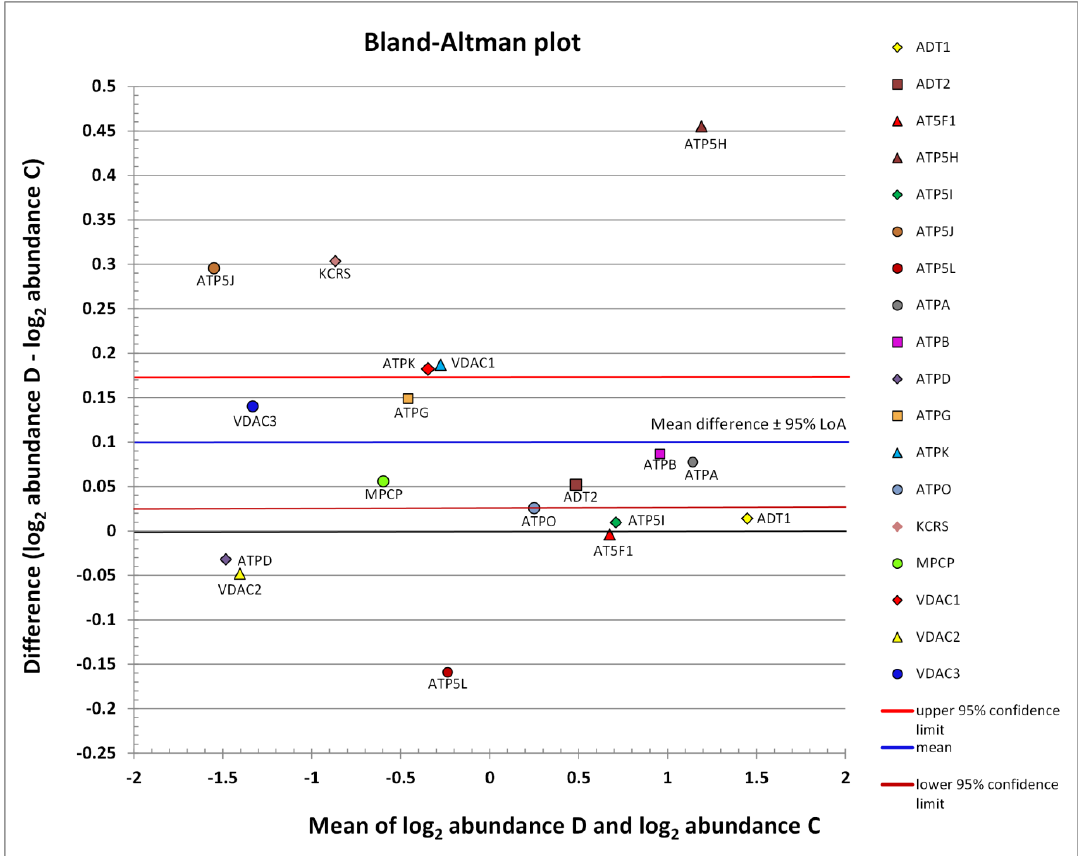
Figure 2. Scatter diagram of the di ff erence between the abundances of a protein in conditions D and C plotted against the average of the two measurements, both on a log scale. Horizontal lines are drawn at the mean di ff erence and at the limits of agreement (95% LoA: 0.0263 to 0.1725). The line of the mean clearly shows an absolute systematic di ff erence of + 0.0994 for the investigated mPTP protein components ( n = 18) in the two conditions (paired t -test p -value = 0.0106). The most di ff erently abundant protein was ATP5H, with the di ff erence in favor of the D group; this also achieved statistical significance (c.f., Table 2). The other mPTP proteins with the highest average abundance were ADT1, ATPA, and ATPB. Low-abundance proteins with the largest relative change, both in favor of the D condition, were ATP5J and KCRS. Additive e ff ects on the log scale were converted into multiplicative e ff ects on the original scale. The zero value denoted by the black line corresponds to the line of equivalence (c.f., Figure